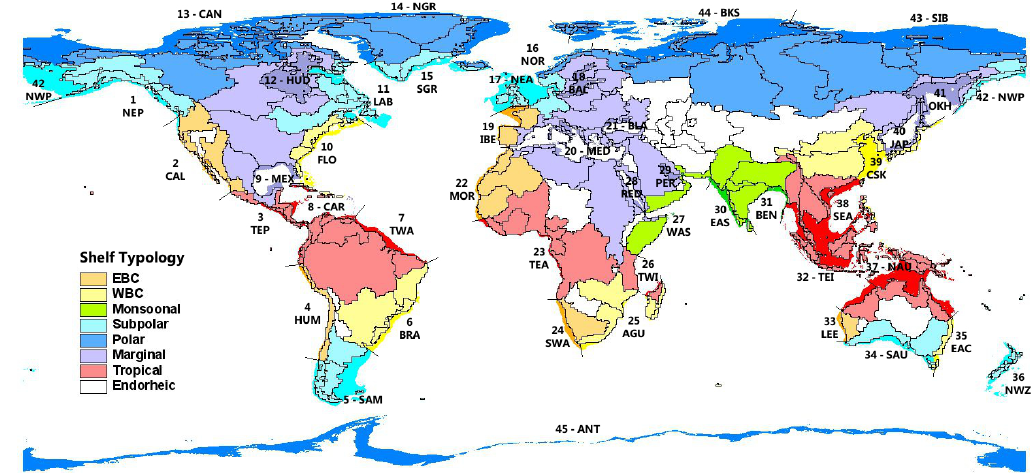
Fig. 2. Geographic limits of MARCATS and COSCAT segments with the typology of